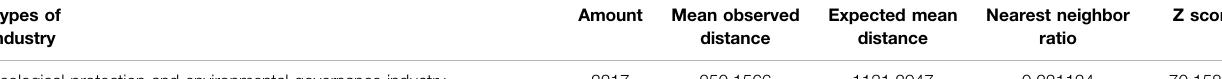
TABLE 1 | Analysis of the nearest neighbor distance of MEG entities in Shanghai. Types of